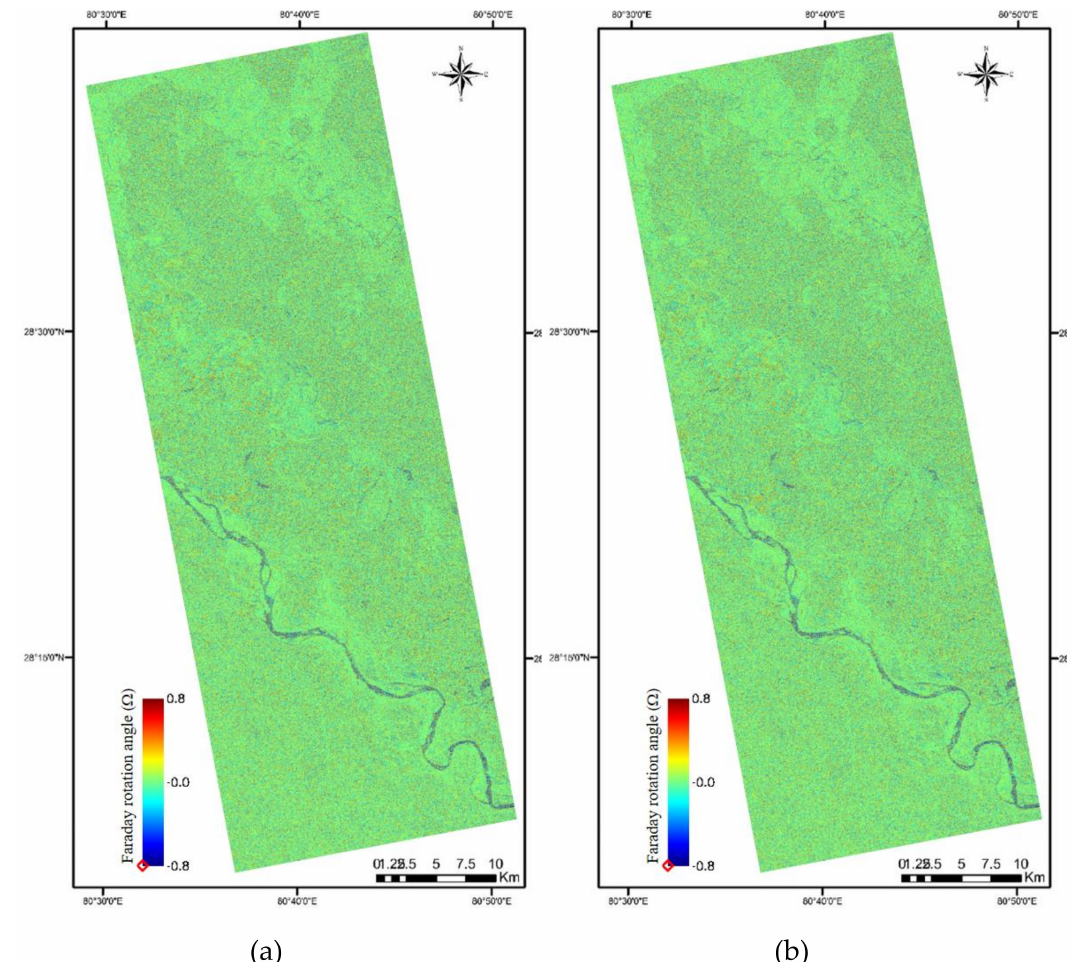
Figure 10. Faraday rotation angle image: ( a ) before compensation, and ( b ) after